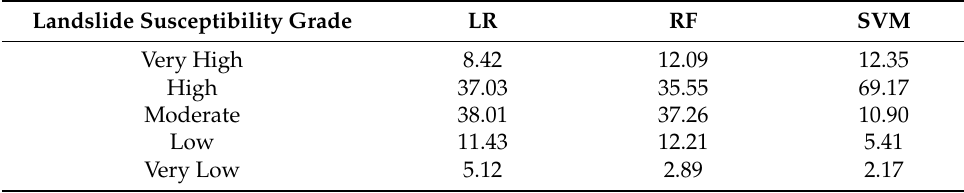
Table 2. Percentage of different model landslide susceptibility grades (%).